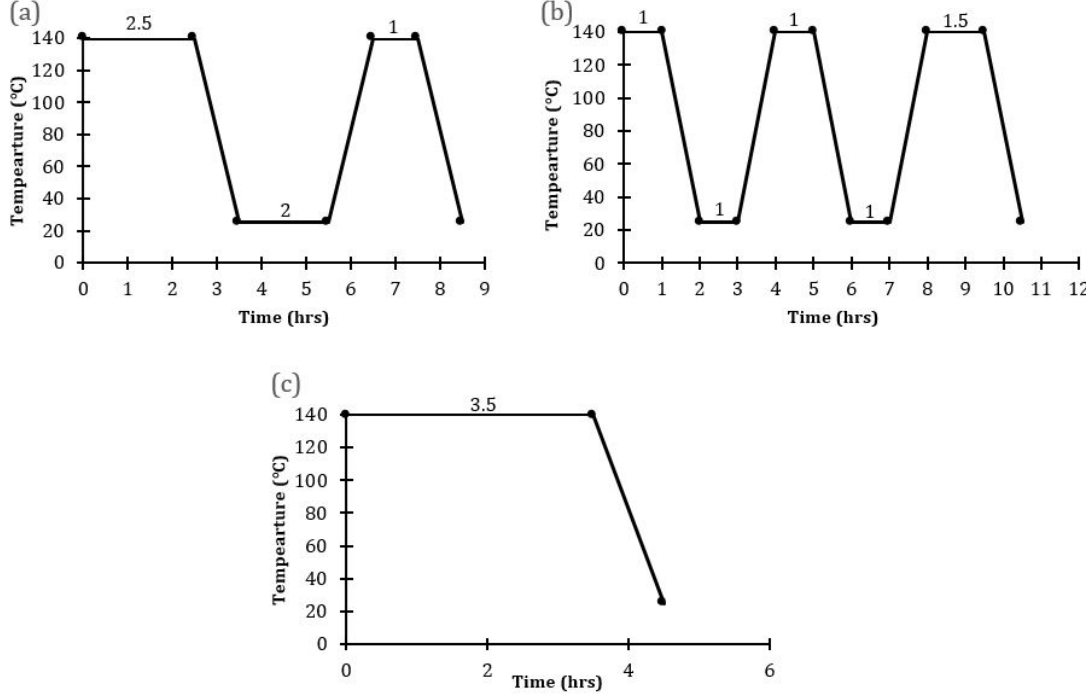
Figure 2. Temperature profiles employed for the synthesis of SOD / α -Al 2 O 3 ( a ) PPH with one interruption (Membranes M1, M2) ( b ) PPH with two interruptions (Membranes M3, M4) ( c ) direct hydrothermal synthesis (Membranes B1, B2).